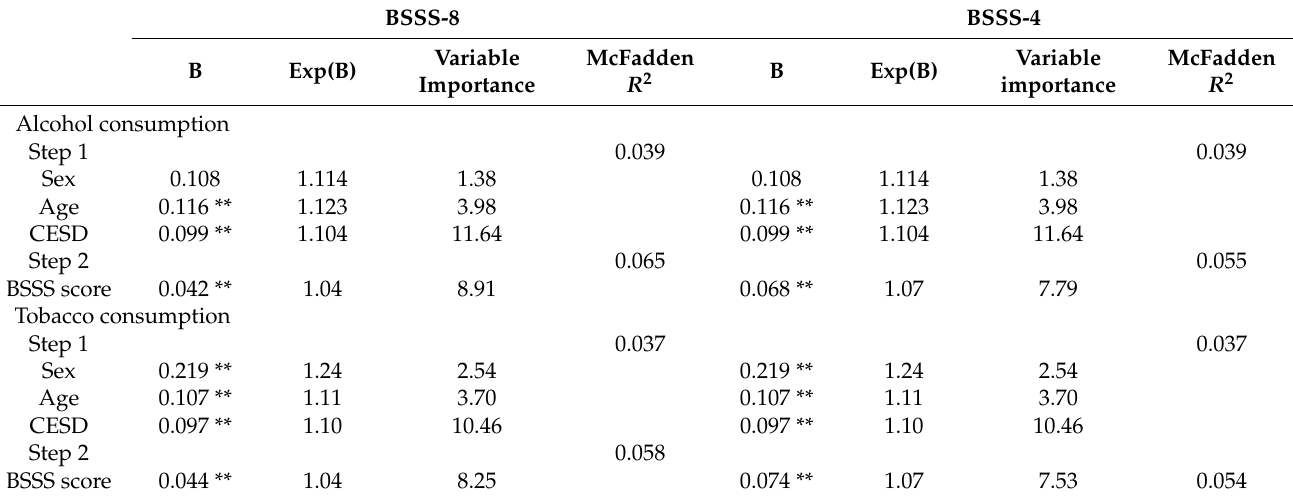
Table 6. Hierarchical logistic regression for incremental